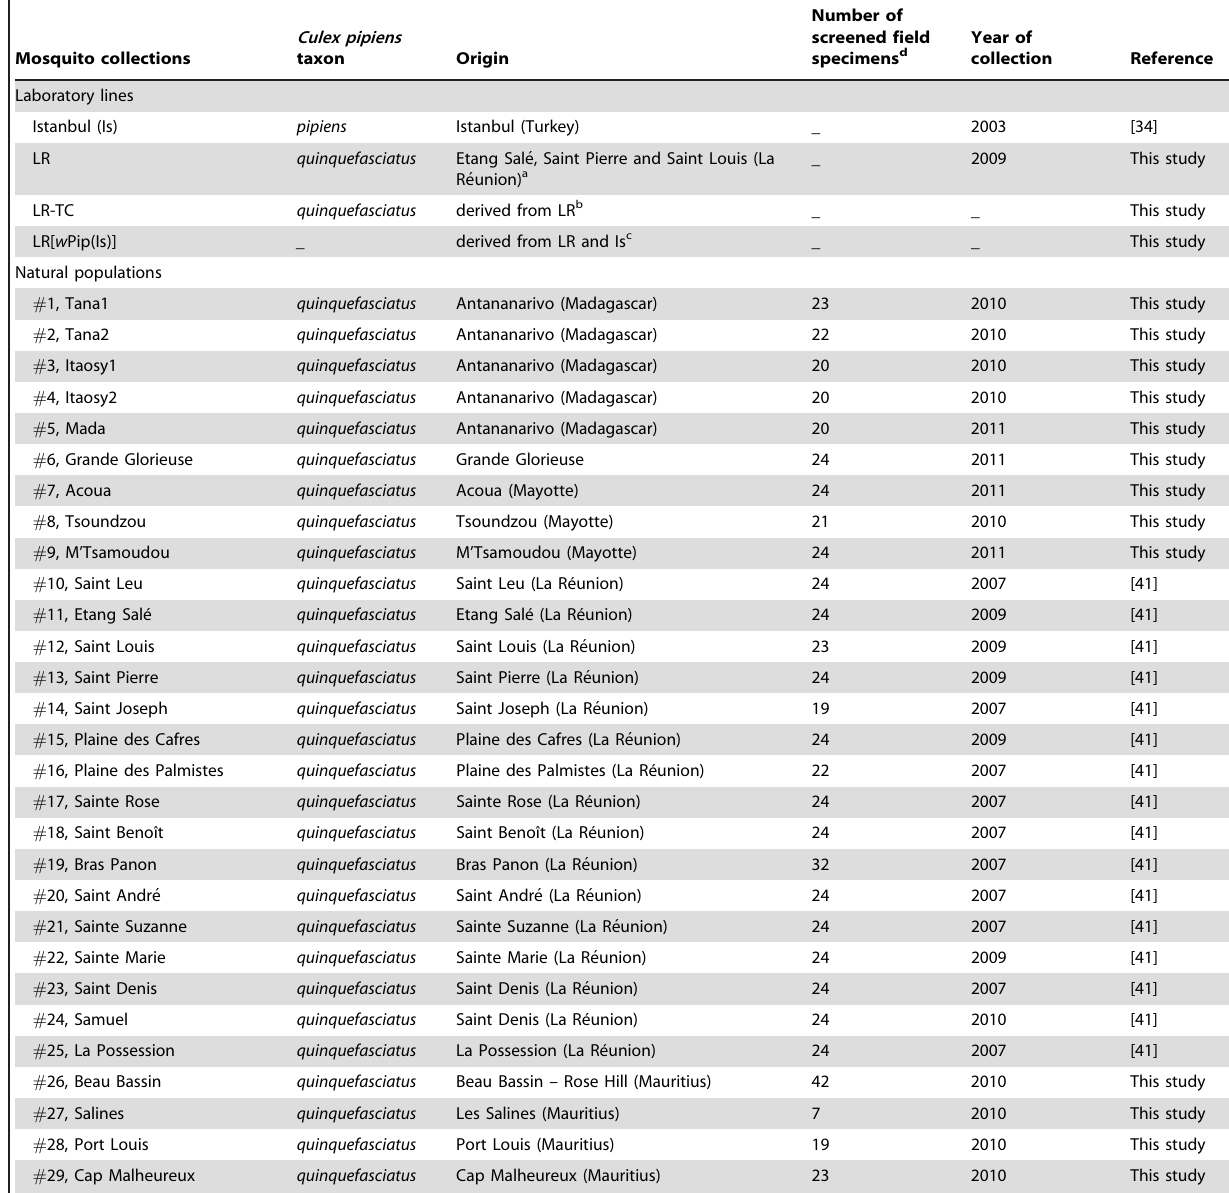
Table 1. Mosquito